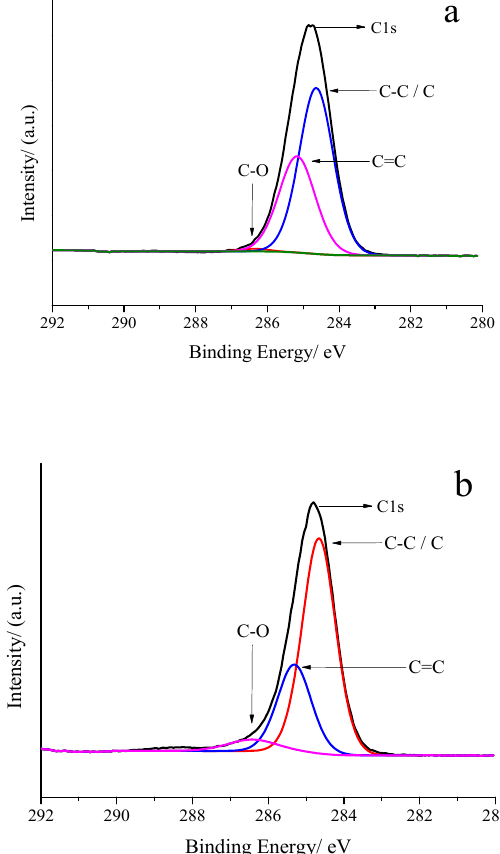
Figure 20. XPS spectra of C1s of original SBS-modified asphalt ( a ) and SBS-g-GOs (0.04% GOs-SH) modified asphalt ( b ).